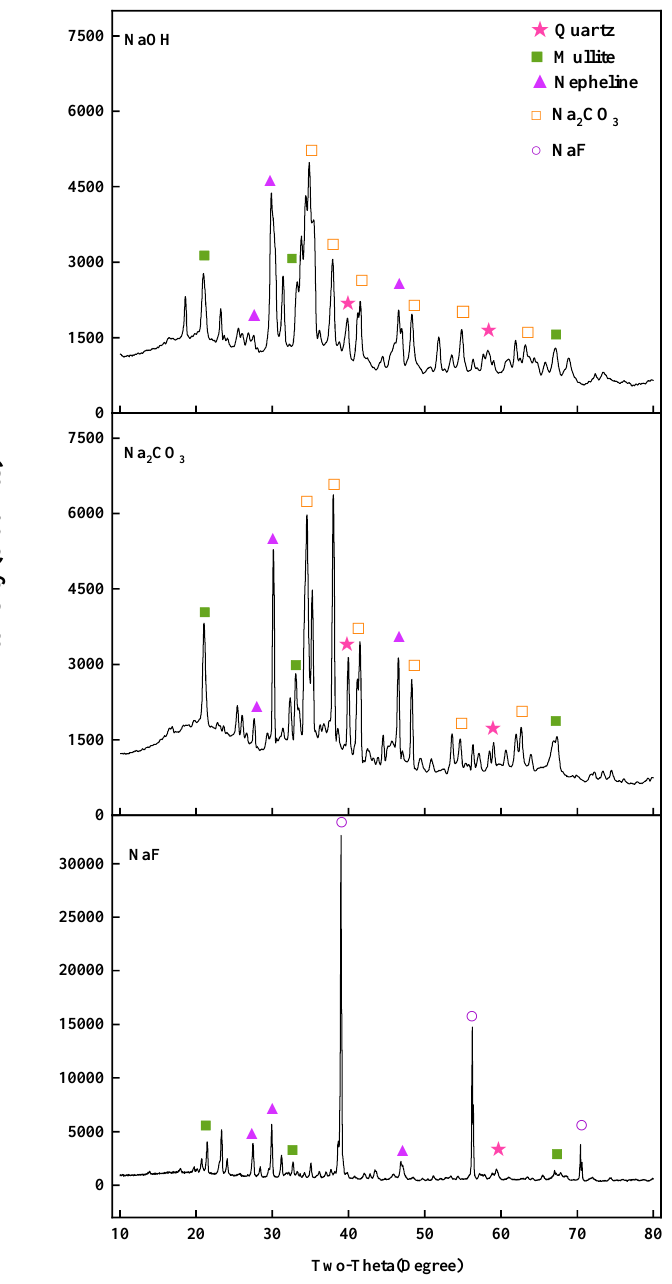
Figure 4. XRD patterns of the alkali roasting residues.